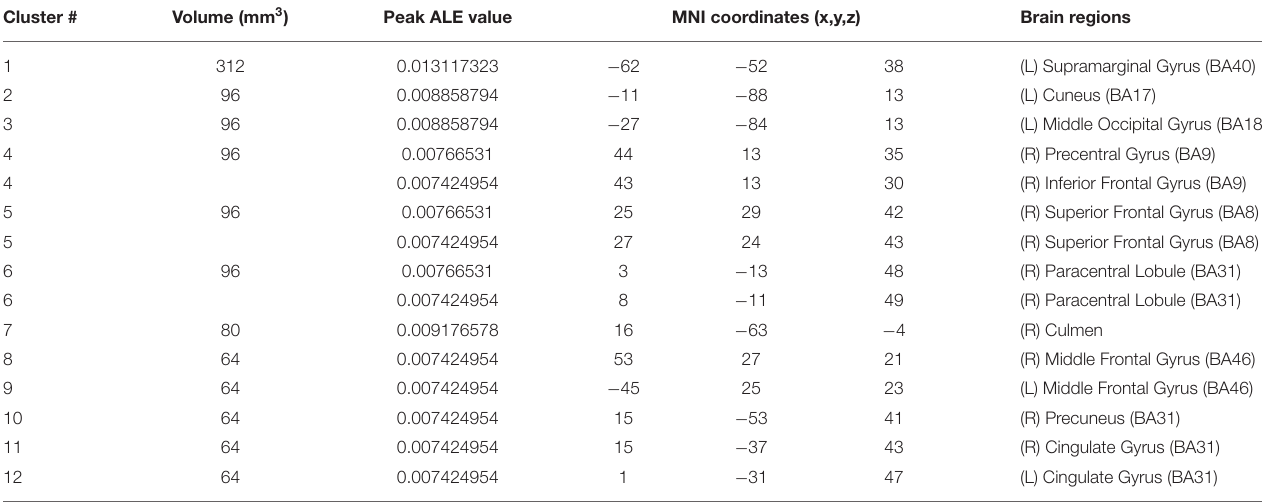
TABLE 3 | Results of ALE analyses on gray matter reduction in OCD. Cluster